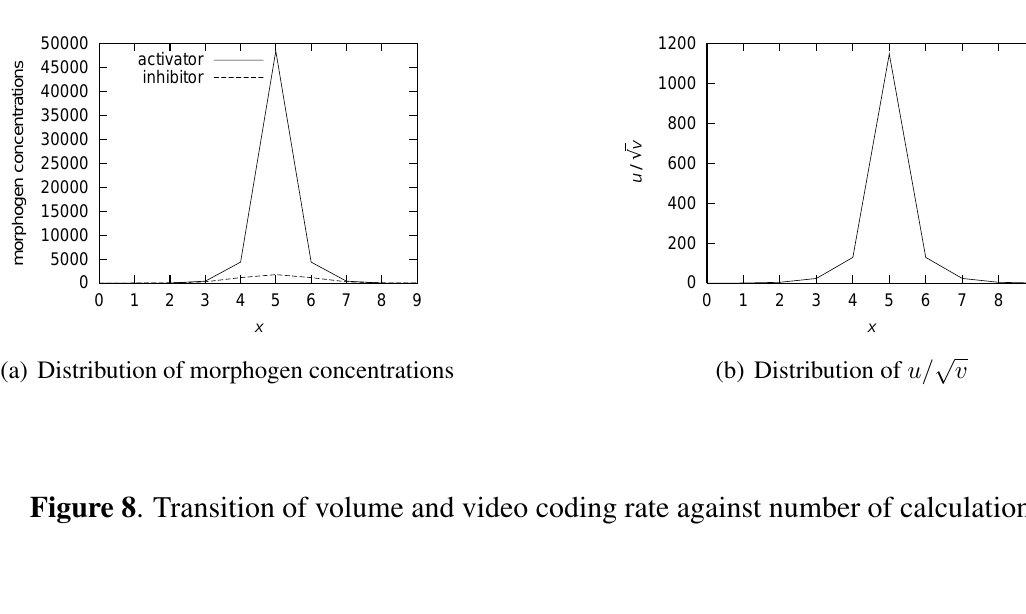
Figure 7 . Simulation results of one stationary target.